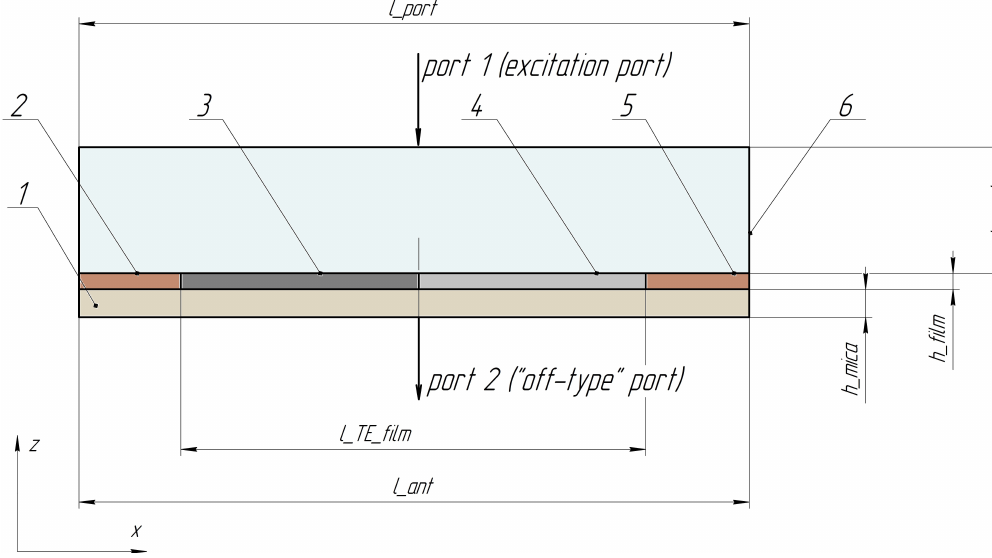
Figure 2. Antenna cross-section in z - x plane; l port = 1000 µ m—the length of the wave excitation port; l TEf ilm = 800 µ m–the length of thermoelectric couple containing two films, l ant = l port —the full antenna length; h f ilm = 150 nm—the thickness of the films; h mica = 40 µ m—the thickness of mica substrate; h port —the distance between wave excitation and antenna, the value of h port was changing within the